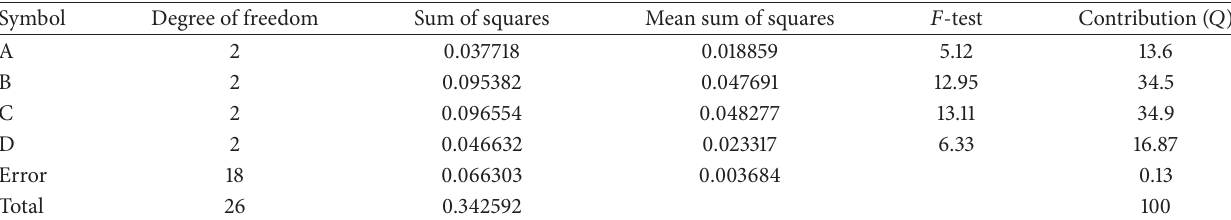
Table 4: Result of ANOVA.